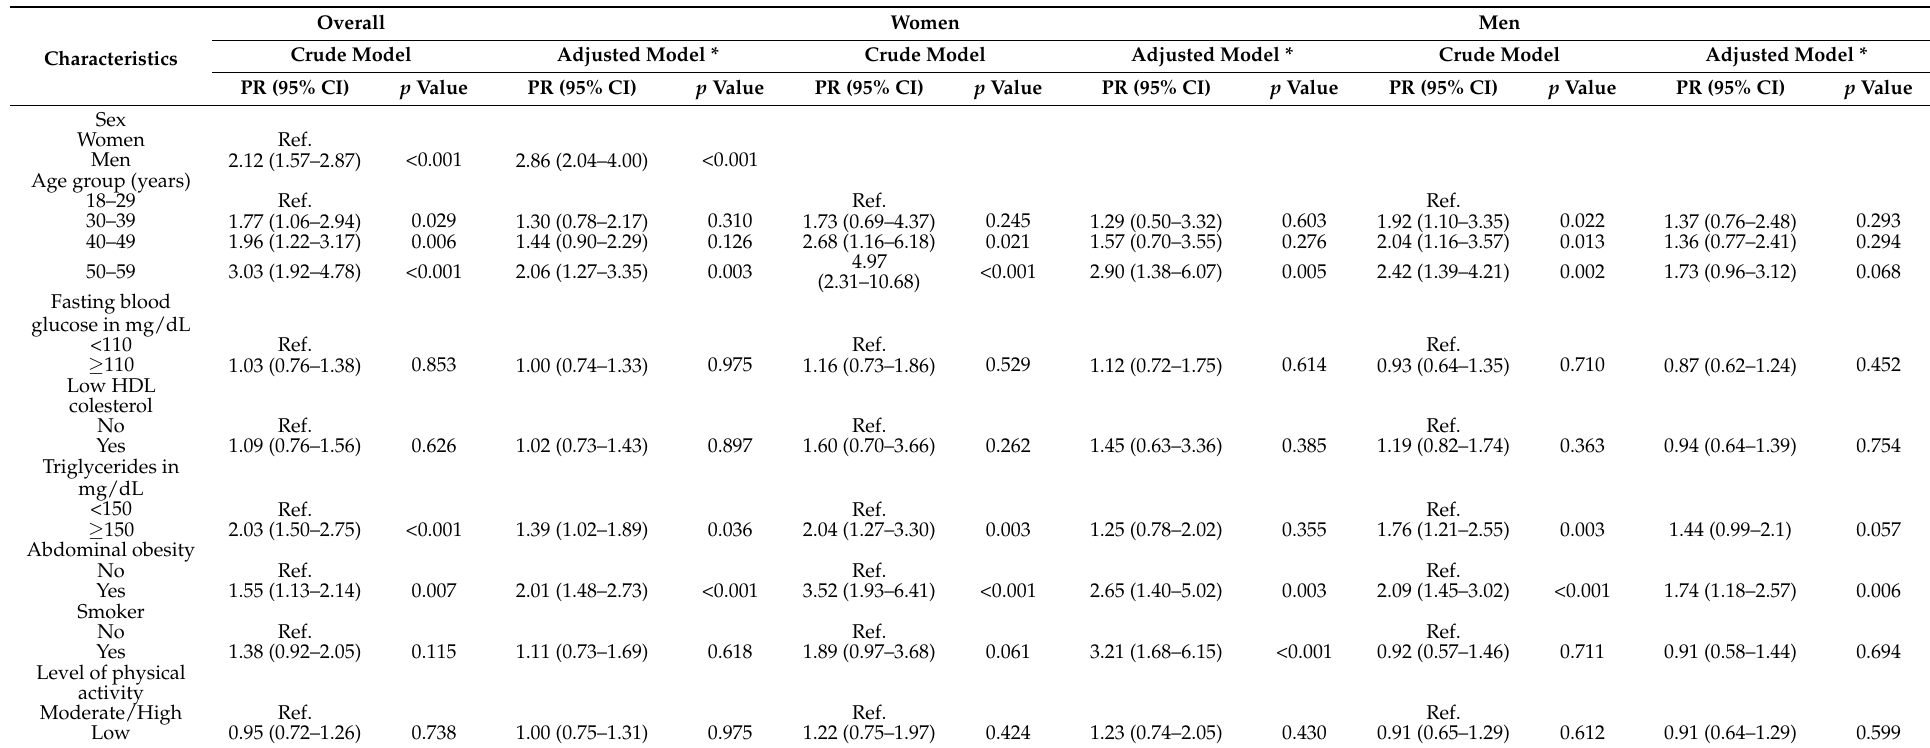
Table 3. Association between cardiometabolic risk factors and prehypertension, 2017–2018